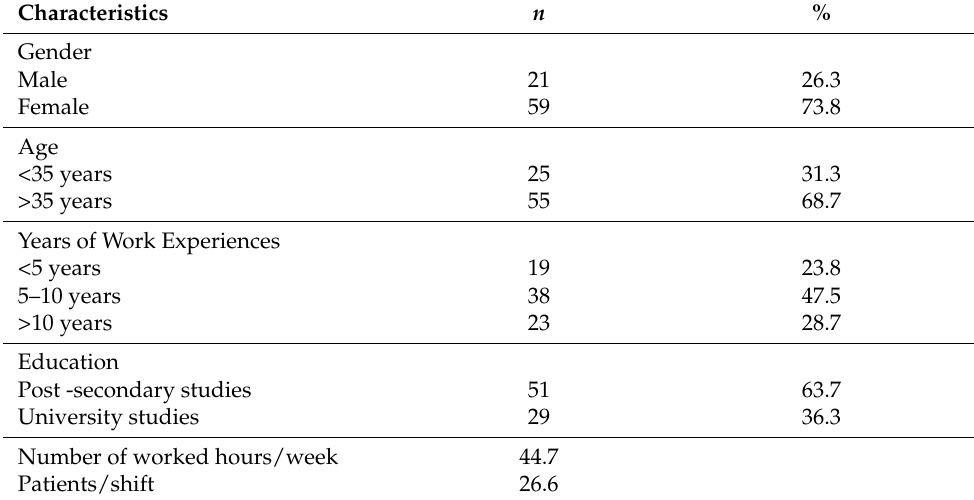
Table 1. Demographic and professional characteristics of participants ( n = 80).